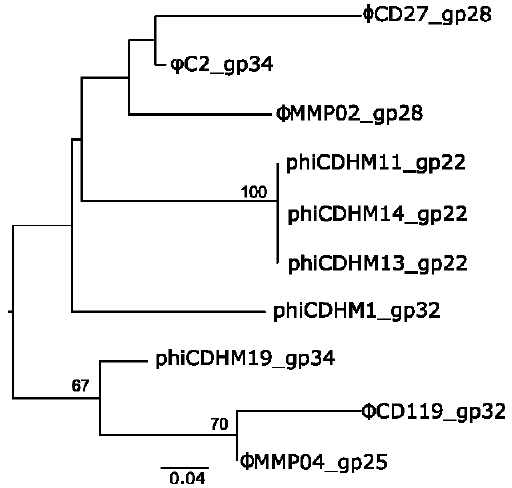
Figure 2. Phylogeny of shared C. difficile myovirus protein in cluster